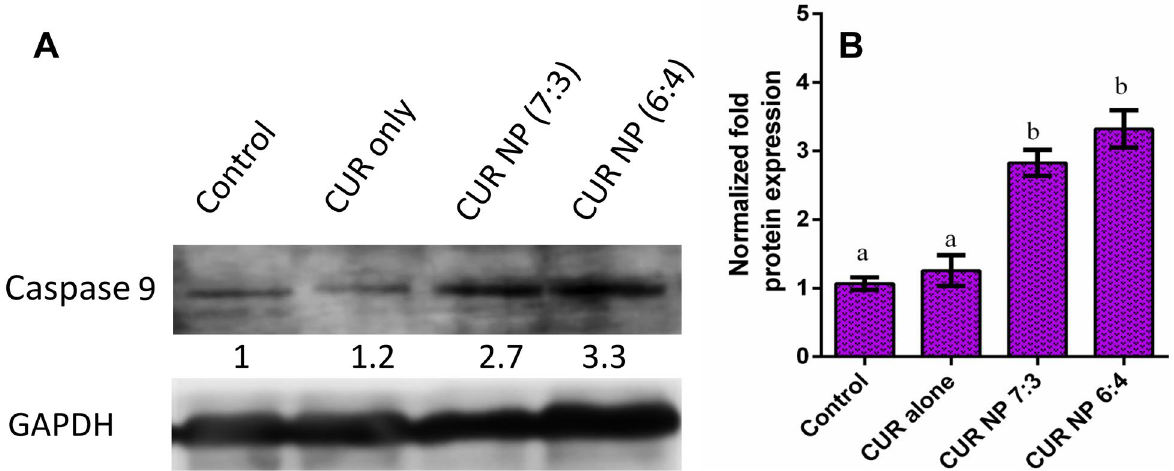
Figure 12. Western blot analysis study, ( A ) MDA-MB-231 cell line treated with nanoparticles showing overexpression of caspase 9 relative to control and cells treated with curcumin alone, ( B ) Normalized protein expression. Statistical analysis was performed using multiple variance analysis (one way ANOVA) with Tukey n =